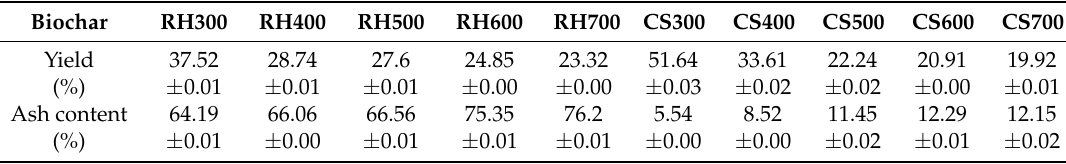
Table 1. Biochar yield and ash content of the biochar samples obtained from rice husk (RH) and cotton straw (CS) at various pyrolysis temperatures (300, 400, 500, 600, and 700 ◦ C). Biochar RH300 RH400 RH500 RH600 RH700 CS300 CS400 CS500 CS600 Yield 37.52 28.74 Ash content 64.19 ±